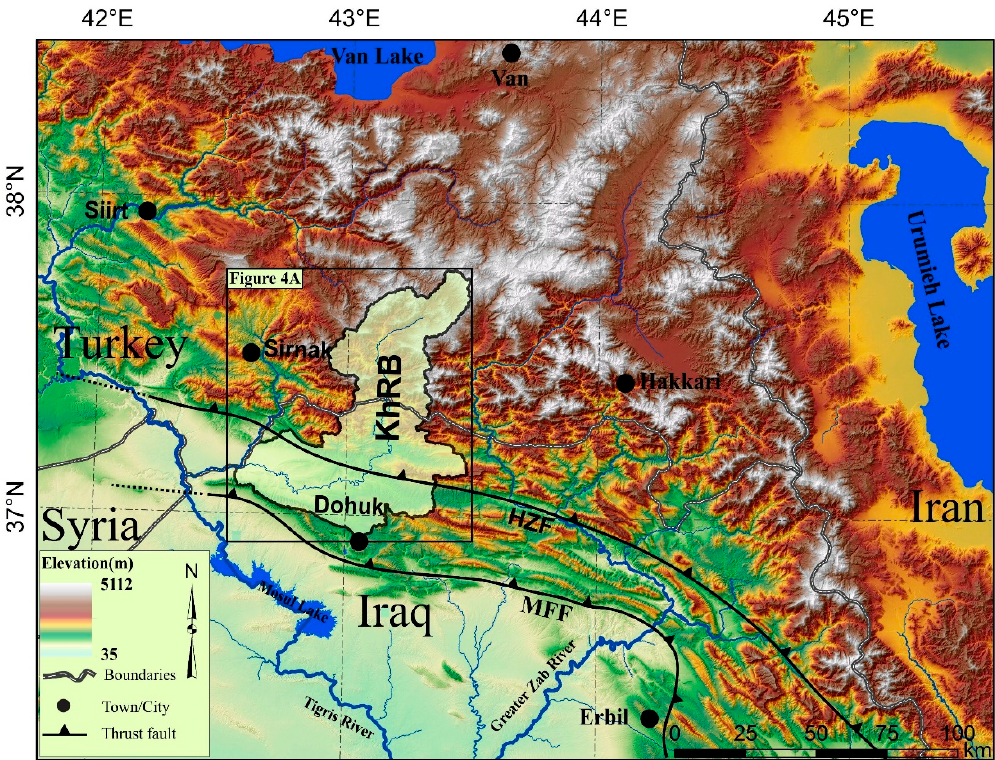
Figure 1. Shaded relief map showing location of the study area in Zagros range.